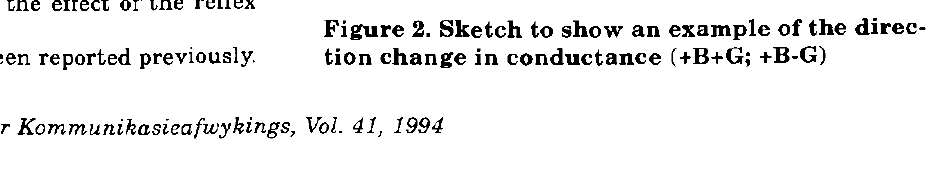
Figure 2. Sketch to show an example of the direc- tion change in conductance (+B +G; +B